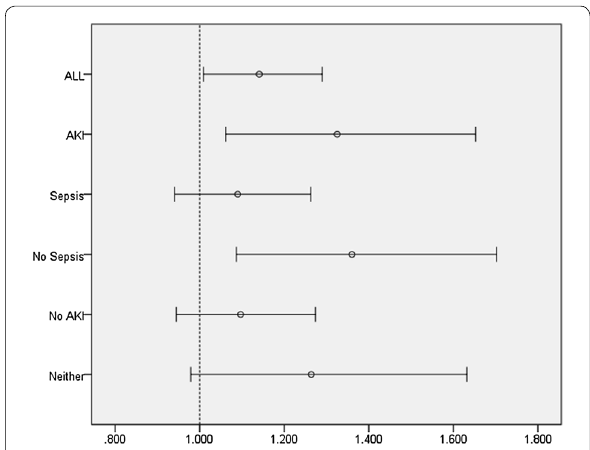
Fig. 3 Forest plot for adjusted odds ratio value of higher mean CVP level ( 10 mmHg) and 28‑day mortality per subgroup. Adjusted ≥ for age, gender, ethnicity, ICU type, congestive heart failure, cardiac arrhythmias, hypertension, valvular disease, pulmonary circulation disease, renal failure and other 24 Elixhauser comorbidities, ICU type, SAPS II score at admission and duration of CVP measurement. AKI acute kidney